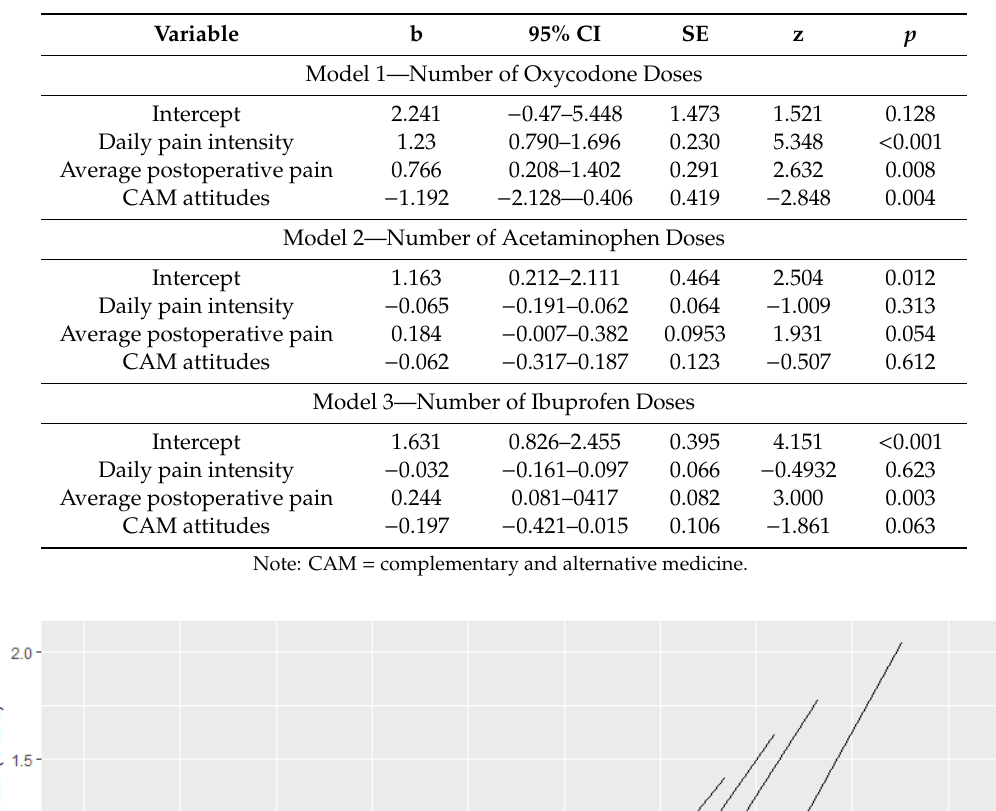
Table 2. Fixed e ff ects from generalized linear mixed-e ff ects models (GLMM) analyses modeling between-person and within-person predictors of medication administration.